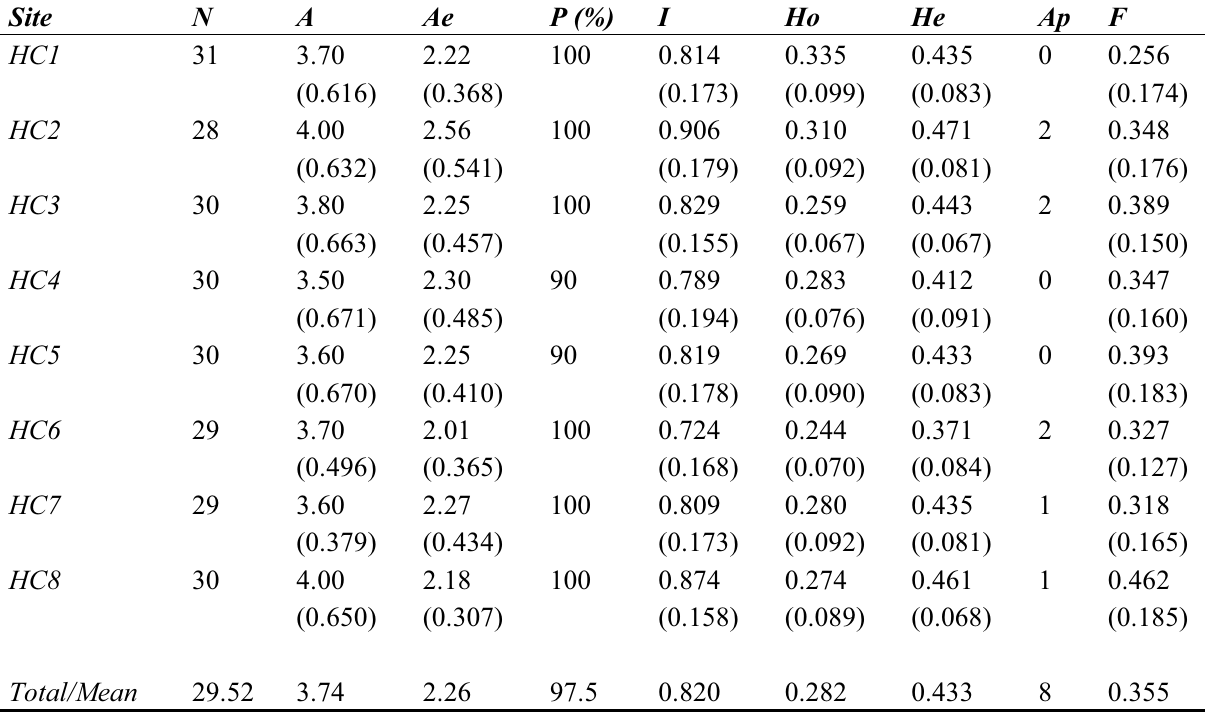
Table 4. Summary of the mean genetic diversity measures across 10 loci for each H. canterburyana site on Lord Howe Island. N , number of samples; A , mean number of alleles per locus; Ae , mean number of effective alleles per locus; P , percentage of